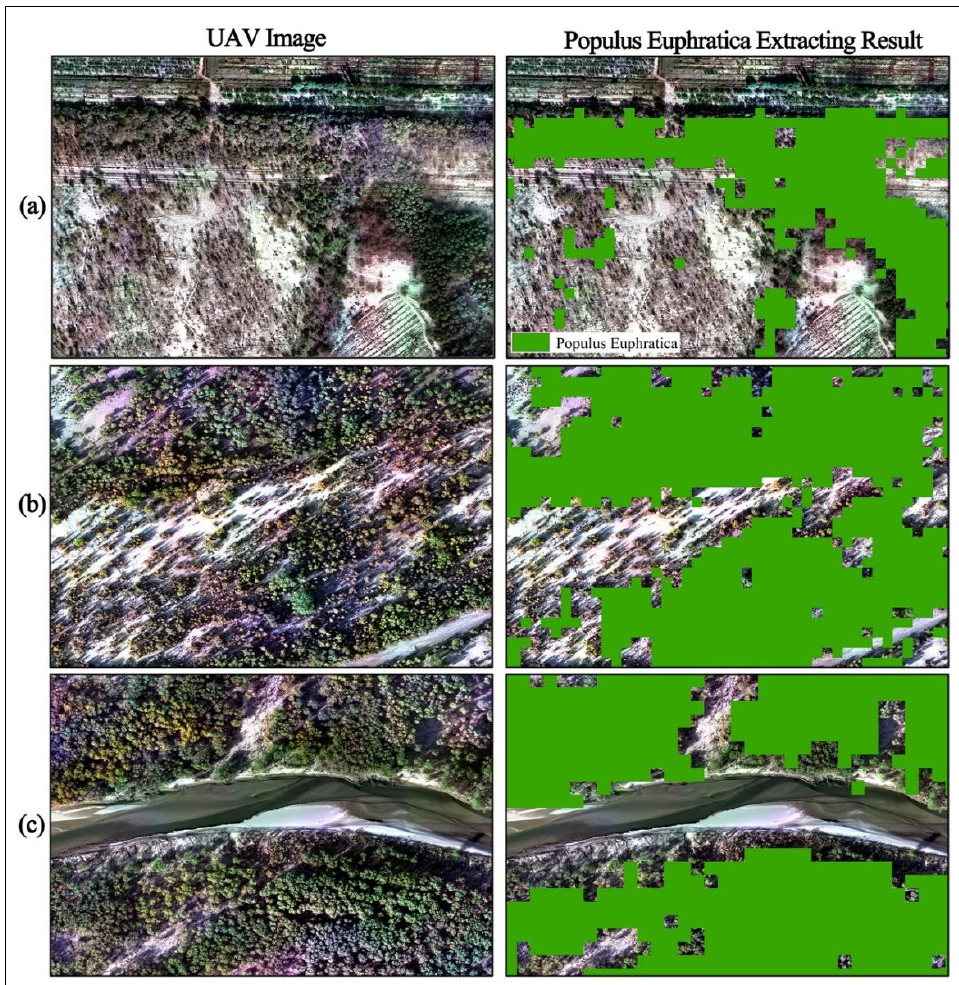
Figure 13. Mapping results for P. euphratica forests with different densities. ( a ) Results for a sparse forest in Xiamale Forest Farm; ( b ) results for a dense–sparse forest in Tarim Park; ( c ) results for a dense forest along the banks of the Yarkank